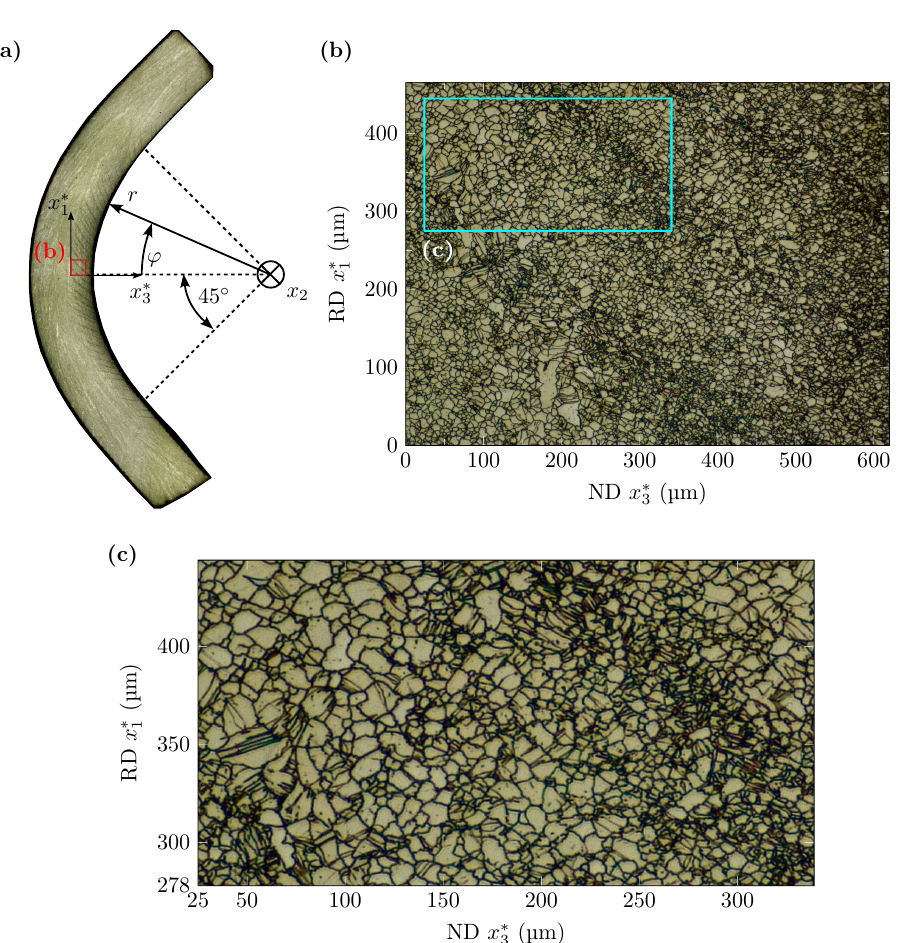
Figure 6. Gauge area and microstructure of the structural component specimen BS9-003 made of AZ31B after the bending process: ( a ) overview of the gauge area with line-shaped BTG; ( b ) band structure with high and low densities of twins due to the bending process; ( c ) magnified view of areas of high and low density of